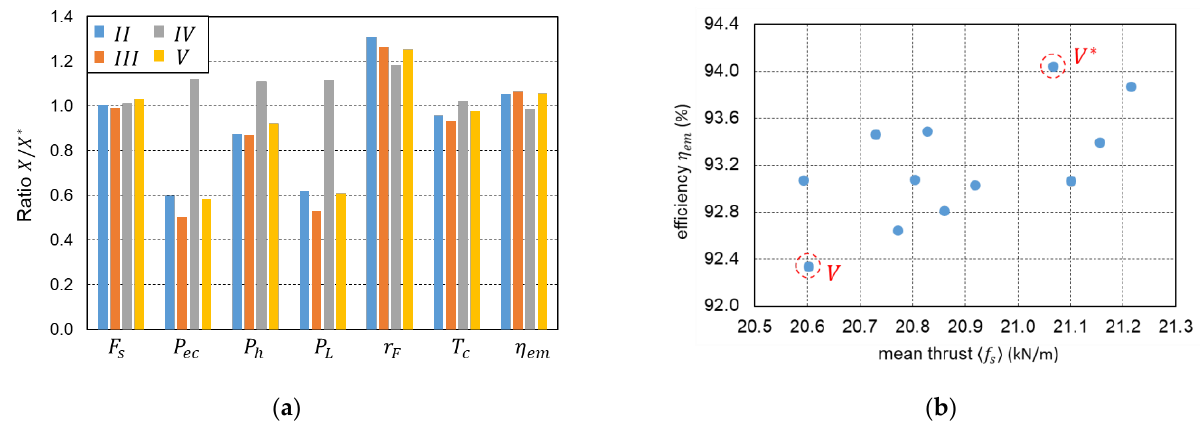
Figure 13. Optimization of the MRSP cross-sections; ( a ): performance comparison of the types II – V with respect to the type I ; ( b ): thrust and efficiency considering the type V geometric sizes; 𝑉 ∗ : optimized configuration.